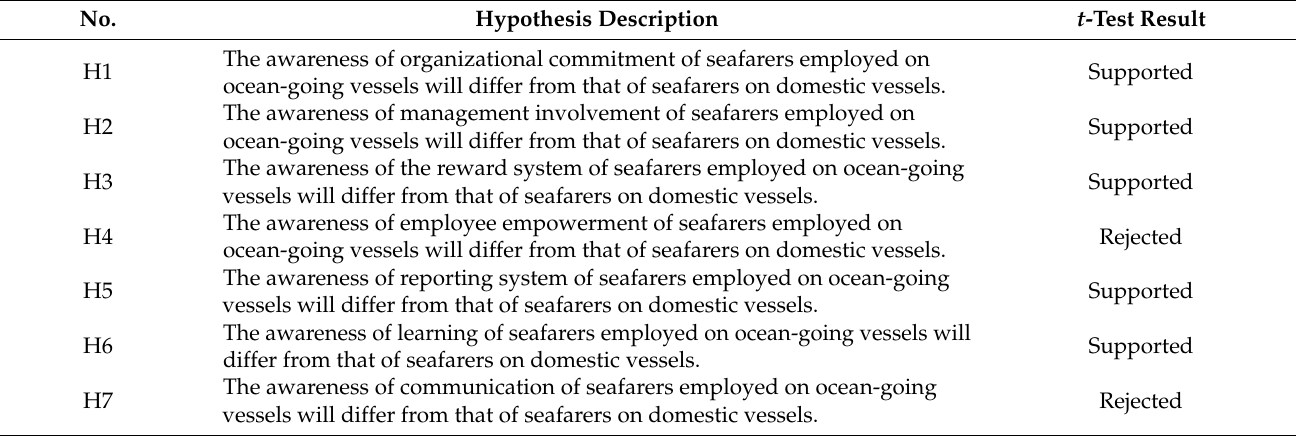
Table 8. Verification of the hypotheses (Source: adapted from: